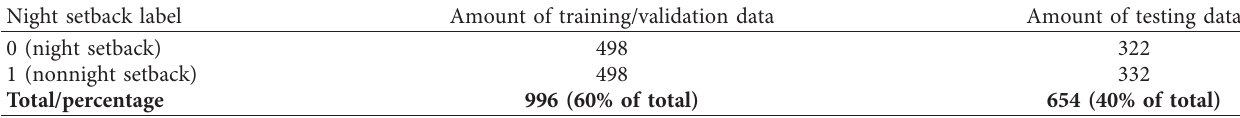
Table 2: Overview of the preprocessed data.